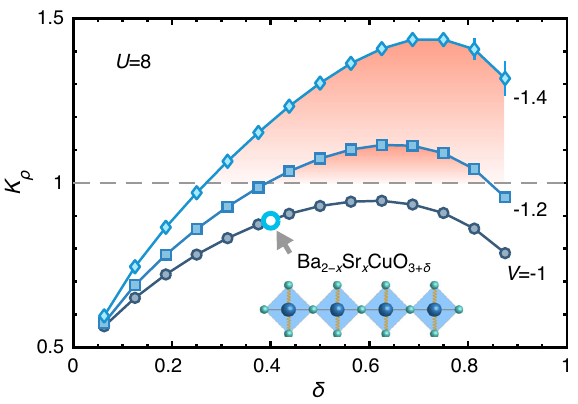
Fig. 6 Prediction for possible triplet superconducting phase in 1D cuprate chain. We show the Luttinger parameter K ρ versus doping δ for different attractive interactions V . In the highlighted regimes with K ρ > 1, there exists superconductivity phase for suf fi ciently strong attraction V and large doping δ . The blue circle represents the cuprate Ba 2 − x Sr x CuO 3 + δ with the parameters V = − 1 46 and δ ≃ 40%, and a slight enhancement of the attraction can drive the compound to the triplet superconductive